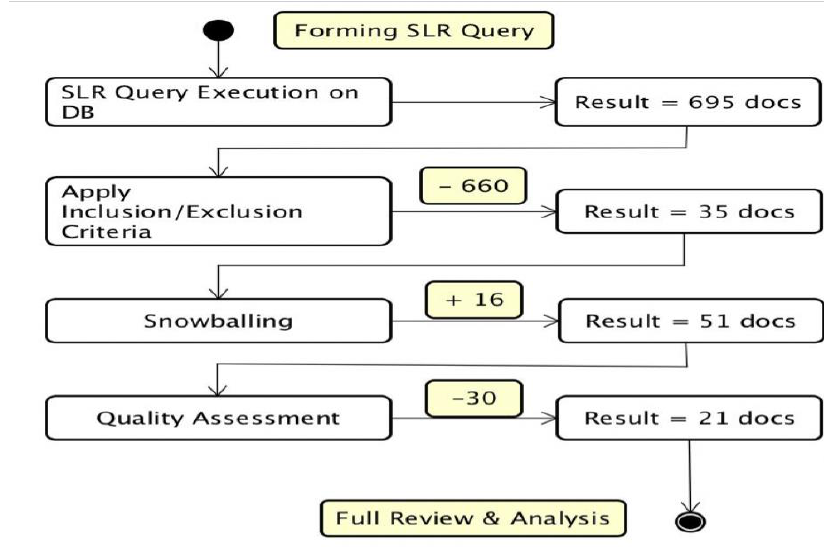
Figure 2 . Paper selection process